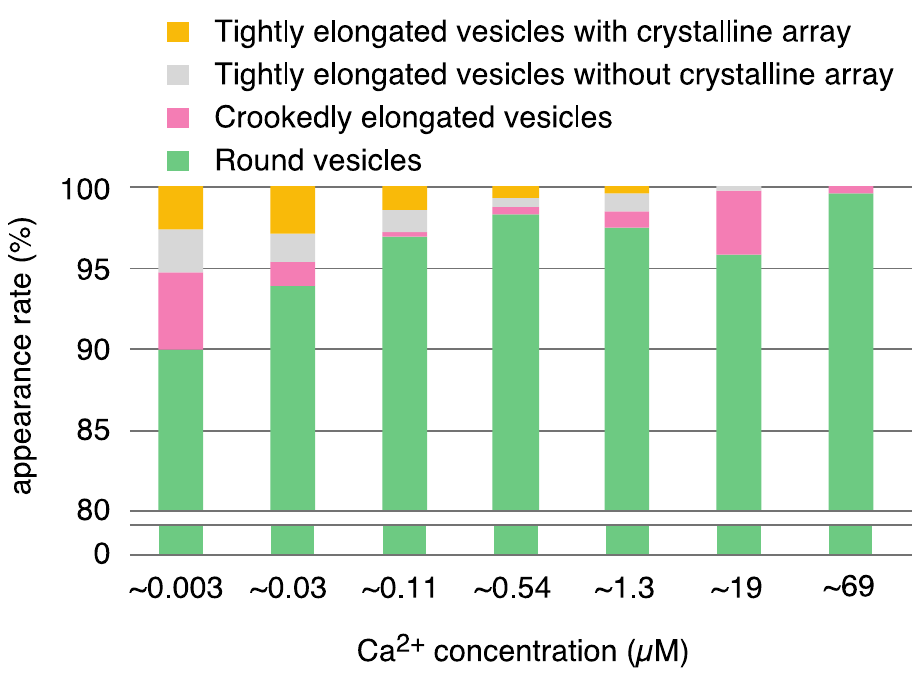
Figure 2. Overview showing the appearance rates of different types of SR vesicle relative to the total number of vesicles at ~0.003–69.0 µ M Ca 2+ . The five-type classification of the vesicles shown in Table S1 was simplified to four types: tightly elongated vesicles with crystalline arrays (yellow), tightly elongated vesicles without a crystalline array, but including vesicles with an assembly of crystal patches or unclear arrays (gray), crookedly elongated vesicles (pink) and round vesicles (green). The crookedly elongated vesicles and round vesicles also sometimes had an assembly of crystal patches or unclear arrays. The rates employed are the average percentages (see Table S1) of the number of each vesicular type to the total number of vesicles at the respective calcium concentrations. For convenience, the rates axis has been truncated; the region below 80% is not completely shown for the round vesicles.